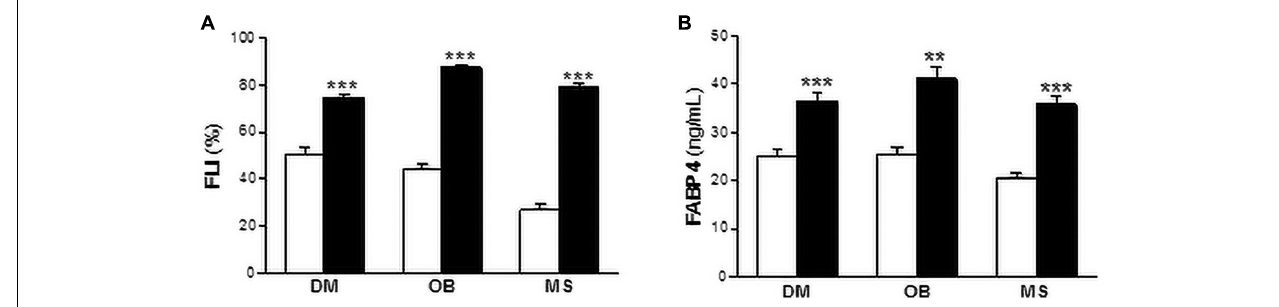
FIGURE 1 | Both FLI and serum FABP4 levels are increased in metabolic patients. FLI (A) and serum FABP4 levels (B) in diabetic (DM), obese (OB) and metabolic syndrome (MS) patients. Black bars correspond to metabolic patients and white bars to non-metabolic individuals. Data are expressed as the means ± SEM. **P < 0.01, ***P < 0.001 vs control non-metabolic patients.